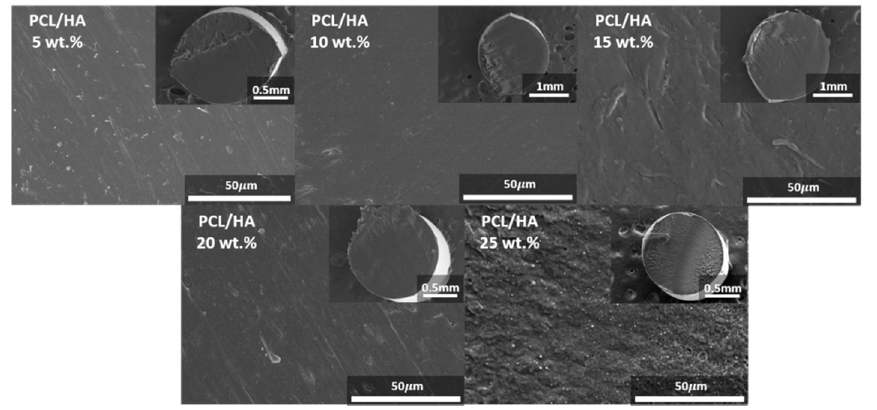
Figure 3. Cross-sectional SEM images of the fabricated filaments containing various HA wt.%. The insets show the overall shapes of the filaments at a low magnification.